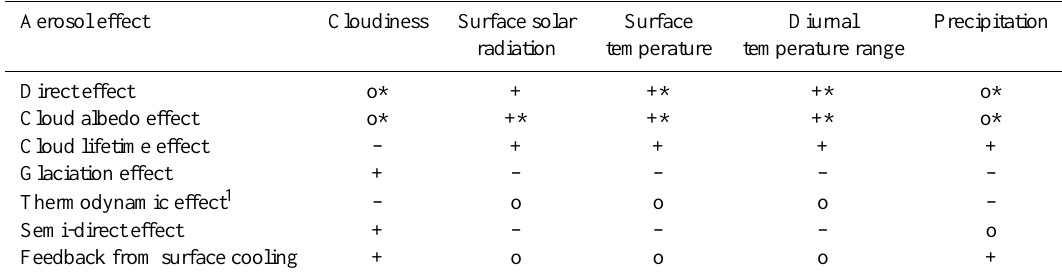
Table 2. Weekly cycle expected for selected variables in relation to the different hypothesised aerosol effects (see also Lohmann and Feichter, 2005). “–” indicates an expected reduction on weekends, “+”, an expected increase, “o” a neutral effect. The “*” symbol indicate a relatively high level of scientific